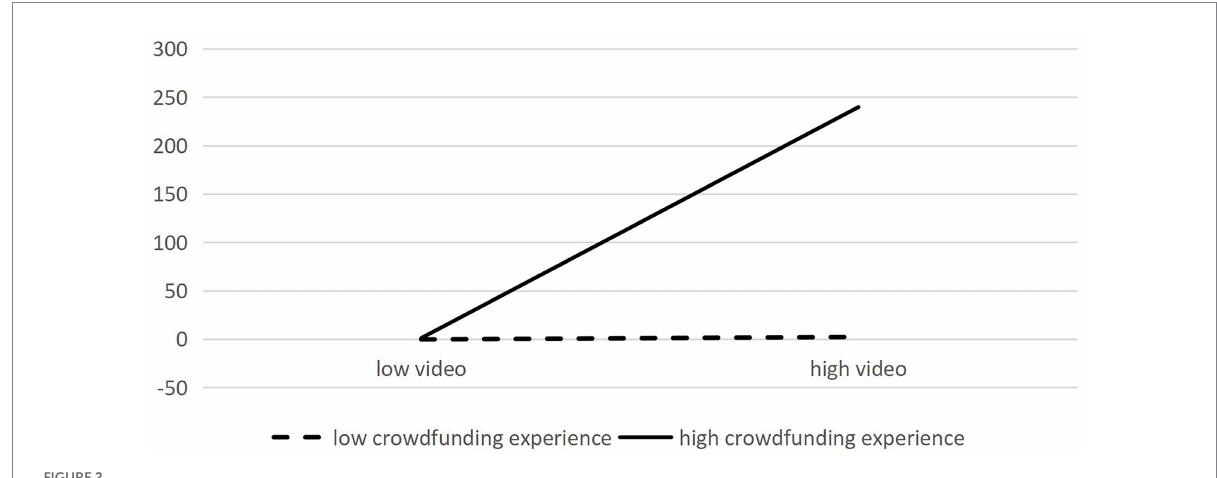
FIGURE 2 Moderating effect of crowdfunding experience on video duration and crowdfunding